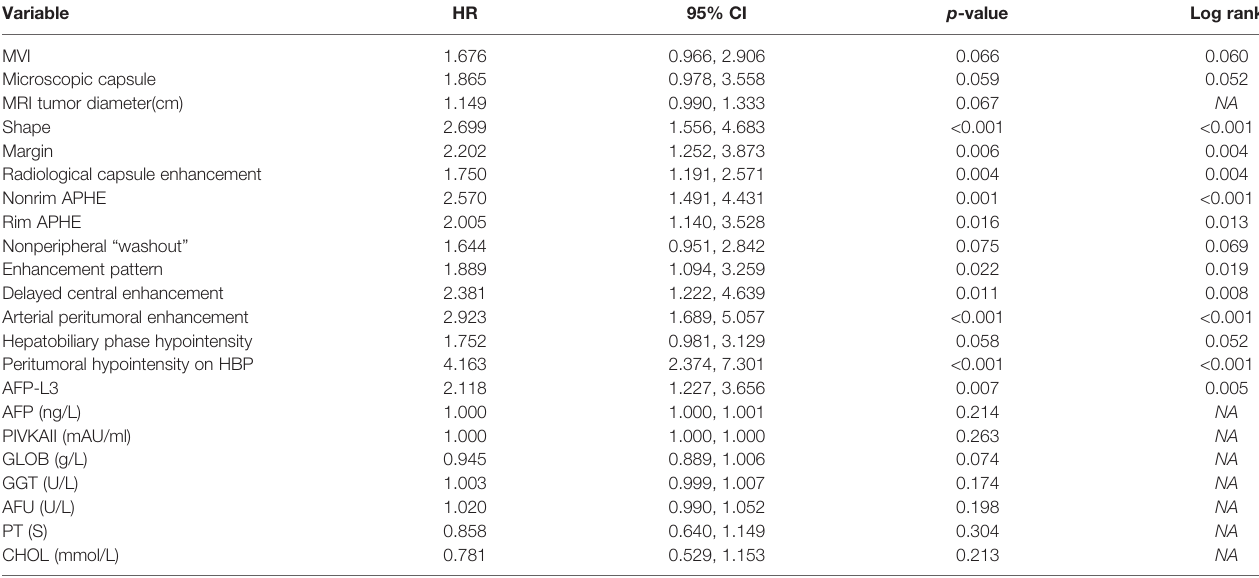
TABLE 2 | Univariate analysis for early